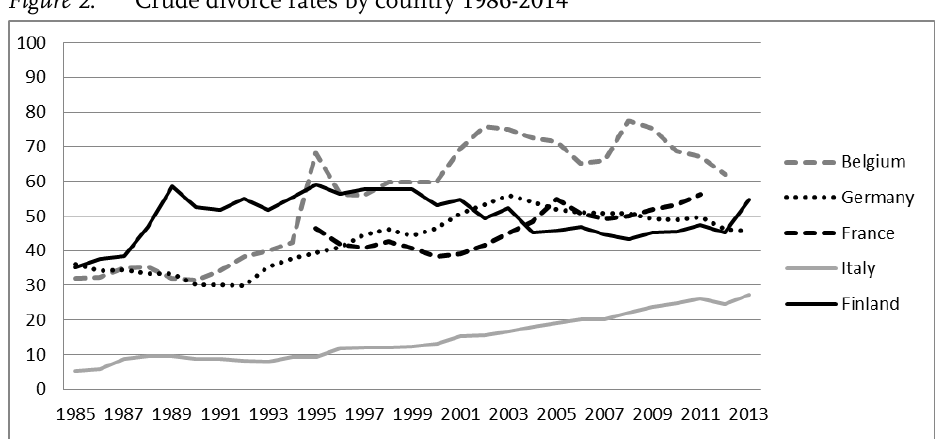
Figure 2 : Crude divorce rates by country